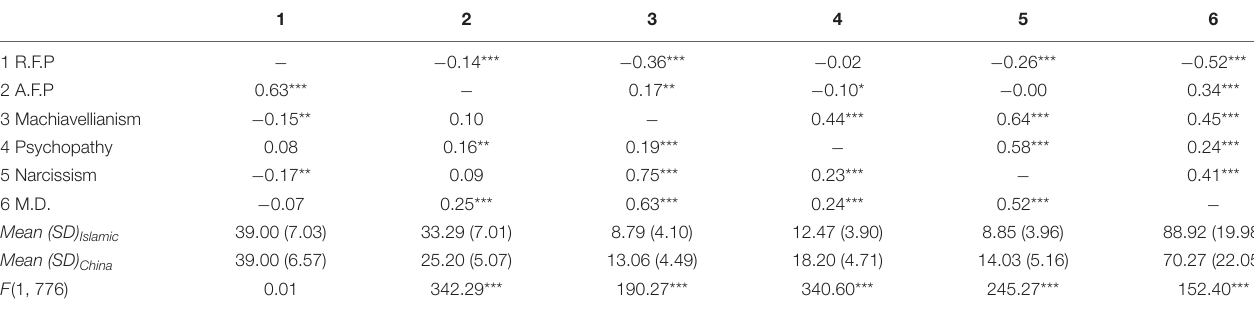
TABLE 1 | Descriptive statistics and Pearson correlations among research variables.